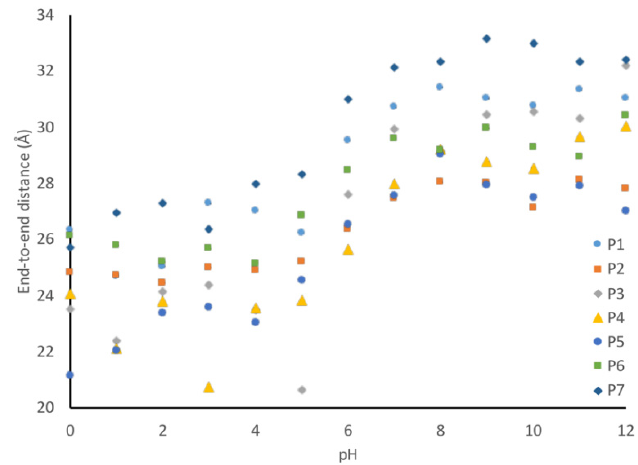
Figure 11. Average end-to-end distances for each peptide. End-to-end distance is defined as the center-of-mass distance between the first and last amino acid in the peptide. Errors in the mean are reported for each data point but are smaller than the symbols. This data show that the peptides all extend when the pH increases.